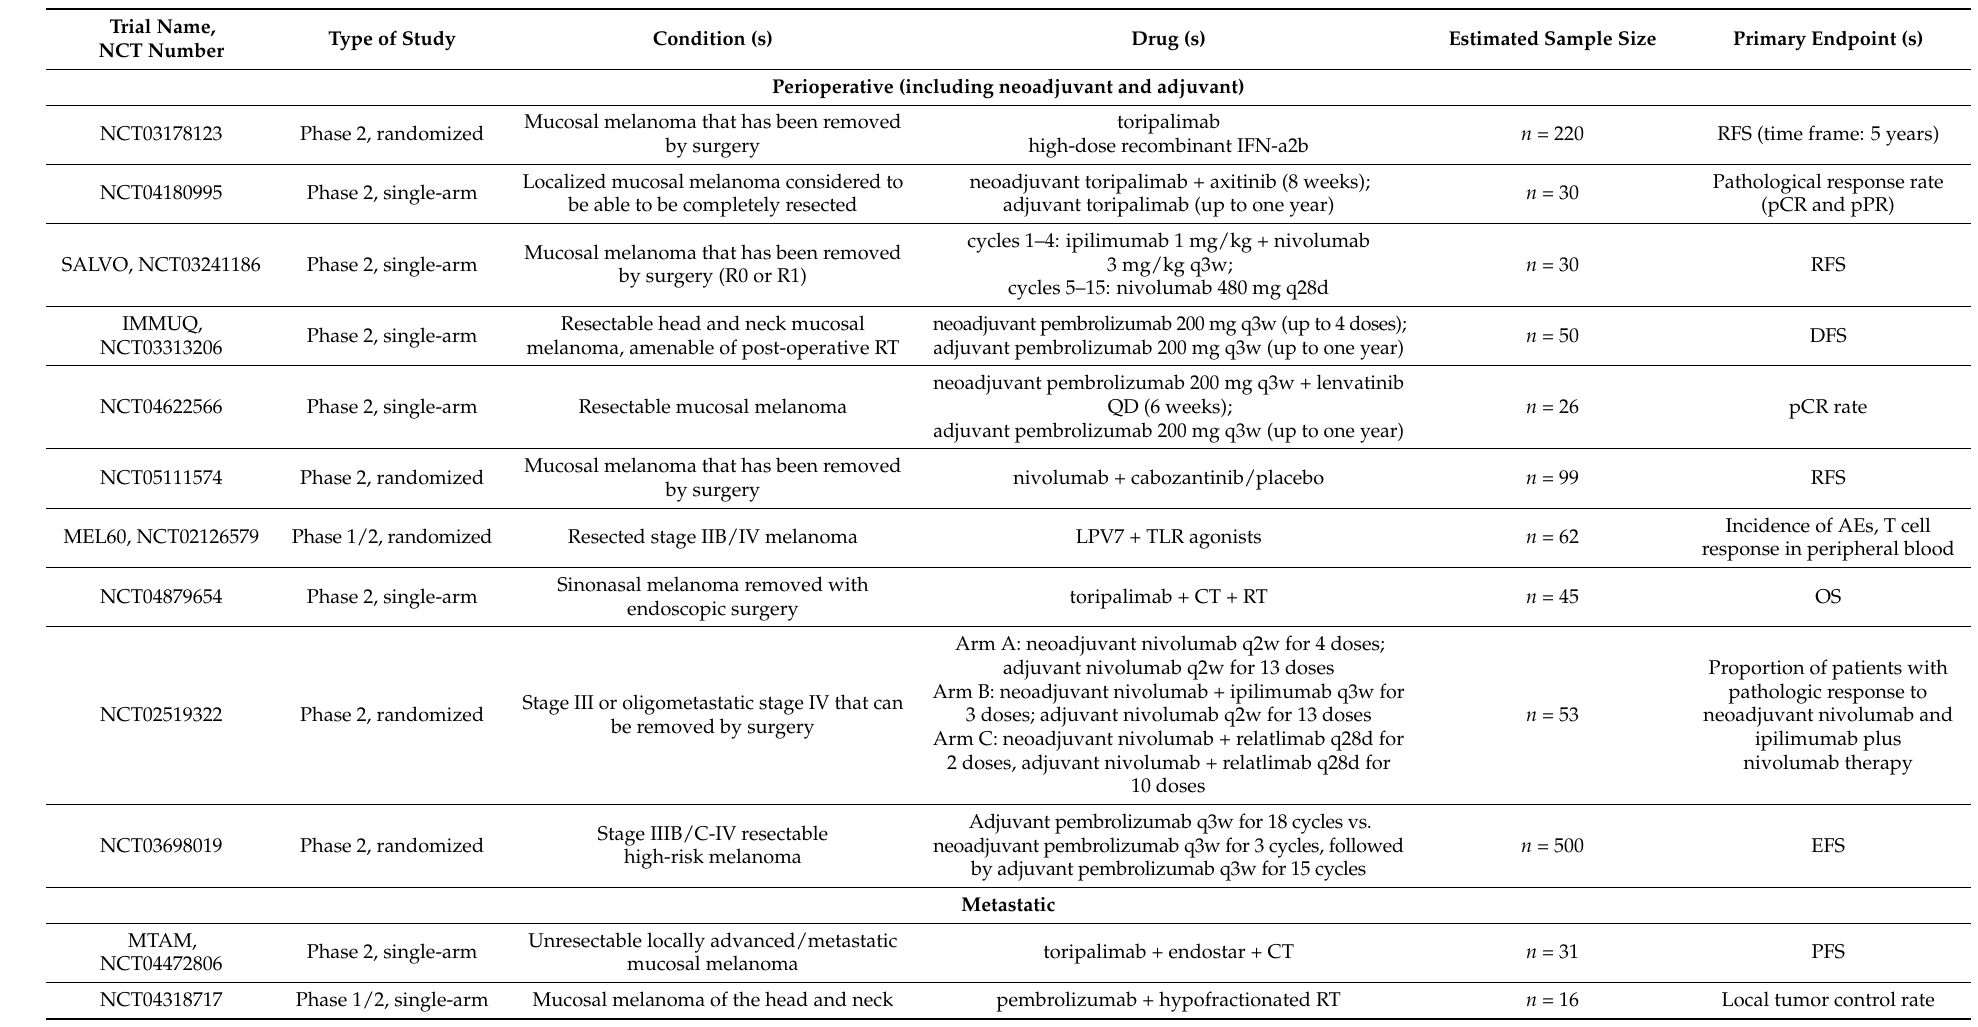
Table 2. Overview of the main ongoing clinical trials (i.e., recruiting and active, not recruiting) for patients with mucosal melanoma in the adjuvant and metastatic setting (source: clinicaltrials.gov; and rctportal.niph.go.jp (accessed on 9 November